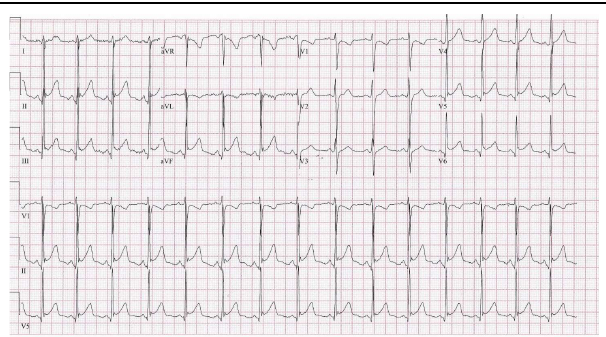
Figure 1 . ST segment elevations on ECG